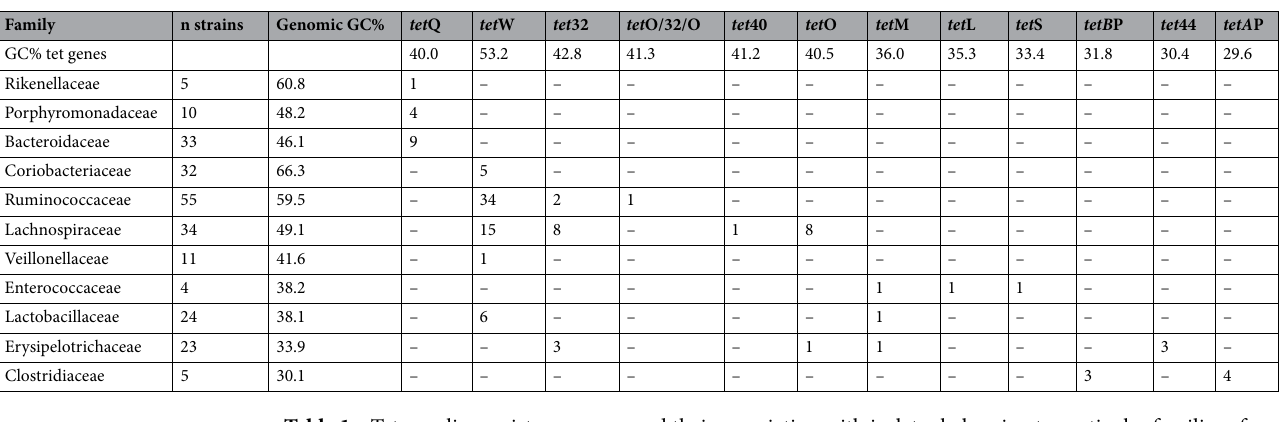
Table 1. Tetracycline resistance genes and their association with isolates belonging to particular families of chicken gut microbiota.